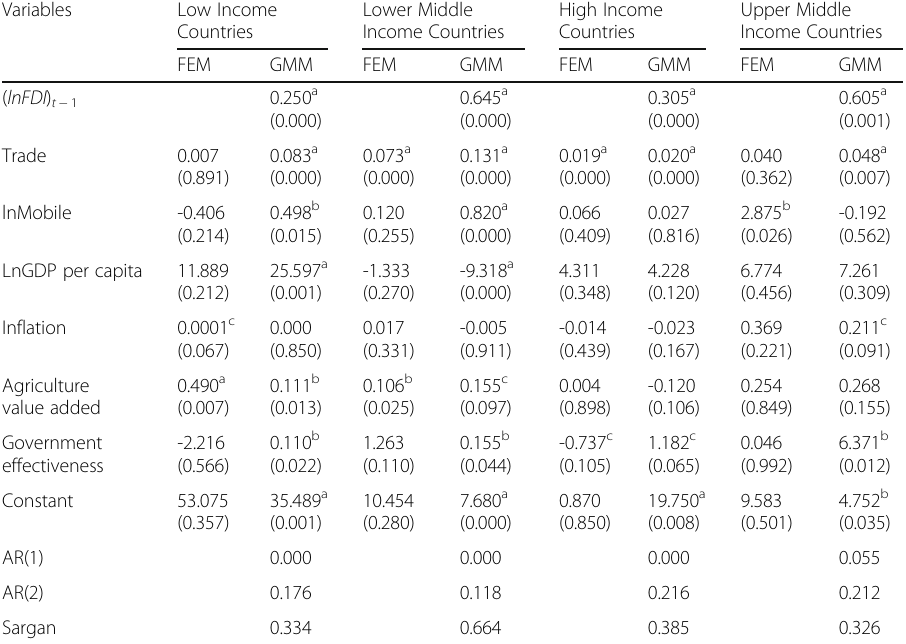
Table 11 Government effectiveness and